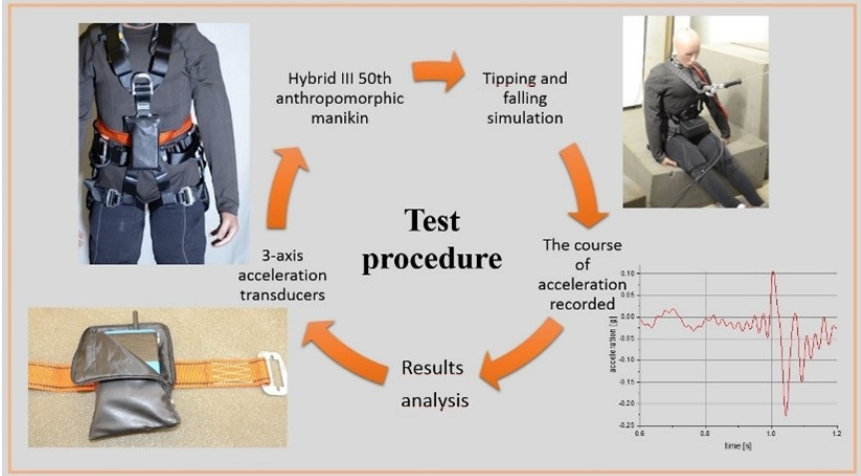
Figure 1. The flow of the research methodology.